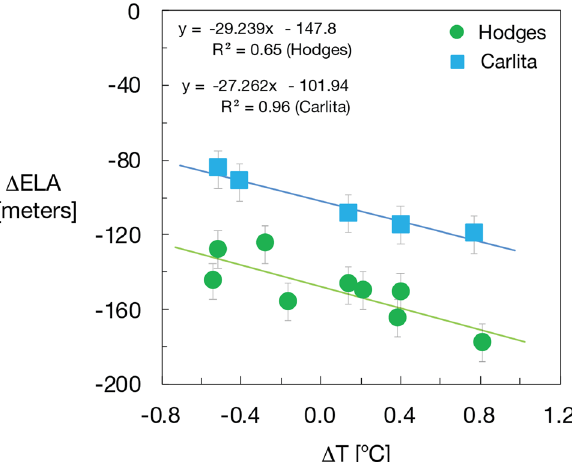
Figure 4. Equilibrium-line altitude (ELA) estimates based on the accumulation area ratio method for individual dated moraines in the Hodges and Carlita catchments versus summer temperature for the corresponding time interval as reconstructed at James Ross Island (see SOM for data) 25 . The trend of gradually ascending ELAs is reproduced for the two glacierized catchments. Carlita glacier is still present, contrary to Hodges, which had completely melted by 2008.